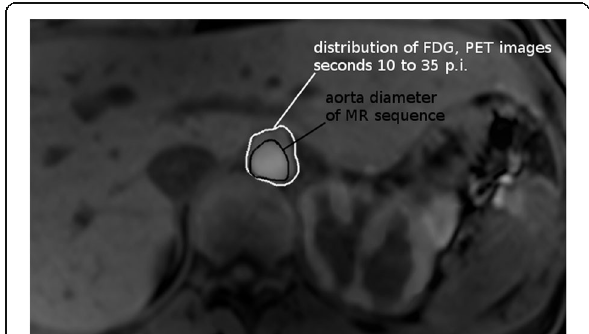
Fig. 4 Fused image of MRI T1 sequence and PET. From the latter, the sum of the second to seventh frame (i.e., seconds 10 to 35) p.i. is shown. Due to partial volume effects, the FDG distribution in the PET images (white contour) clearly exceeds the aorta diameter observed with MRI image (black contour). Also, the initial accumulation of FDG in the cortex is